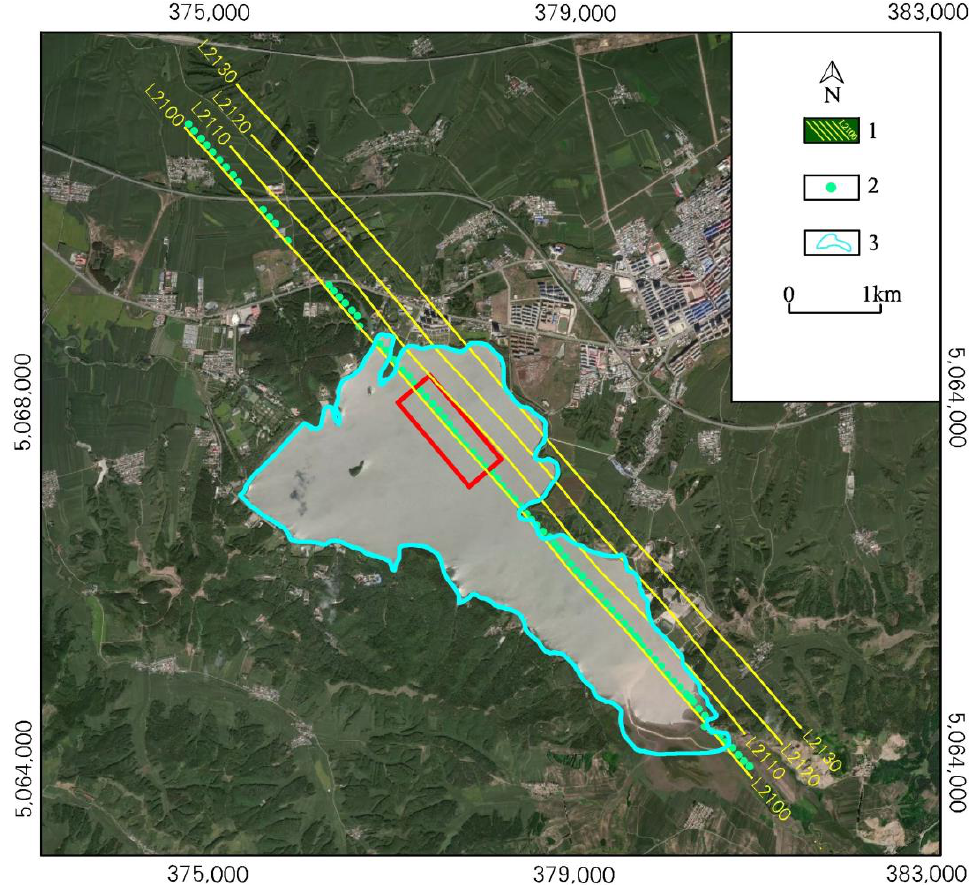
Figure 10. Ground TEM survey diagram. 1 — flown footprint, 2 — ground TEM survey position, 3 — reservoir.